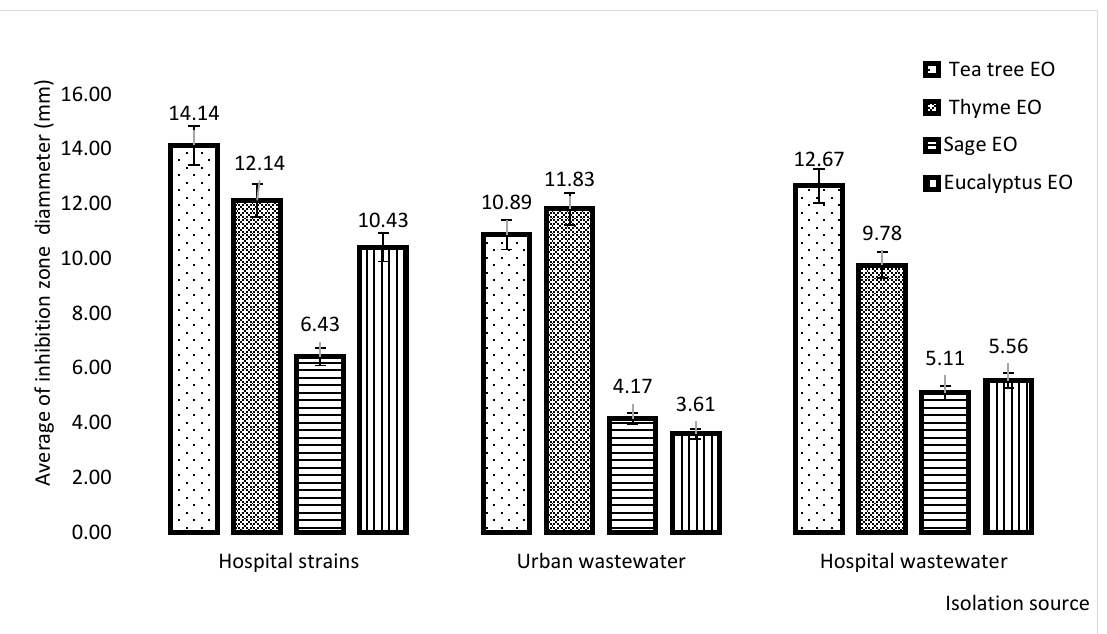
Figure 6. Graphic representation of the average inhibition diameter zone of the EOs in P. aeruginosa strains, regardless their isolation source.